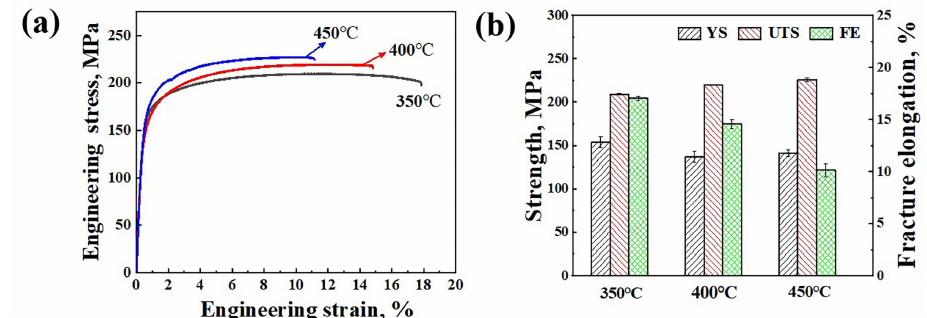
Figure 10. The tensile properties of LMCs hot-pressed at different temperatures along RD: (a) engineering stress-strain curves and (b) variations of YS, UTS and